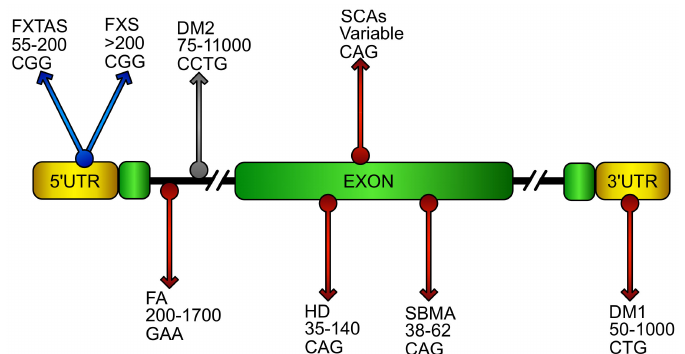
Figure 1. Putative location and sequence of DNA expansions in repeat disorders. Schematic representation of an ideal gene showing DNA repeat expansions that cause diseases. Name of the relative disorder, number of pathogenic repeats, and its sequence are reported in the gene region were the repeats stem in the pathology. The grey arrow represents pathology where oxidative stress has been poorly investigated. Blue arrows characterize diseases with oxidative stress contributions. Red arrows identify pathologies in which NF-E2 p45-related factor 2 (NRF2) involvement has been reported. (FXTAS, fragile X–associated tremor ataxia syndrome; FXS, fragile X syndrome; FA, Friedreich’s ataxia; DM1 / DM2 myotonic dystrophy; HD, Huntington’s disease; SCAs, spinocerebellar ataxias; SBMA, spinobulbar muscular